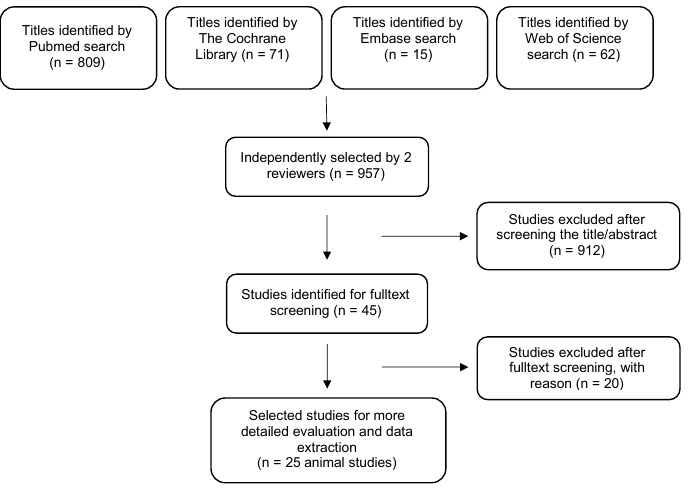
Figure 1. Search strategy